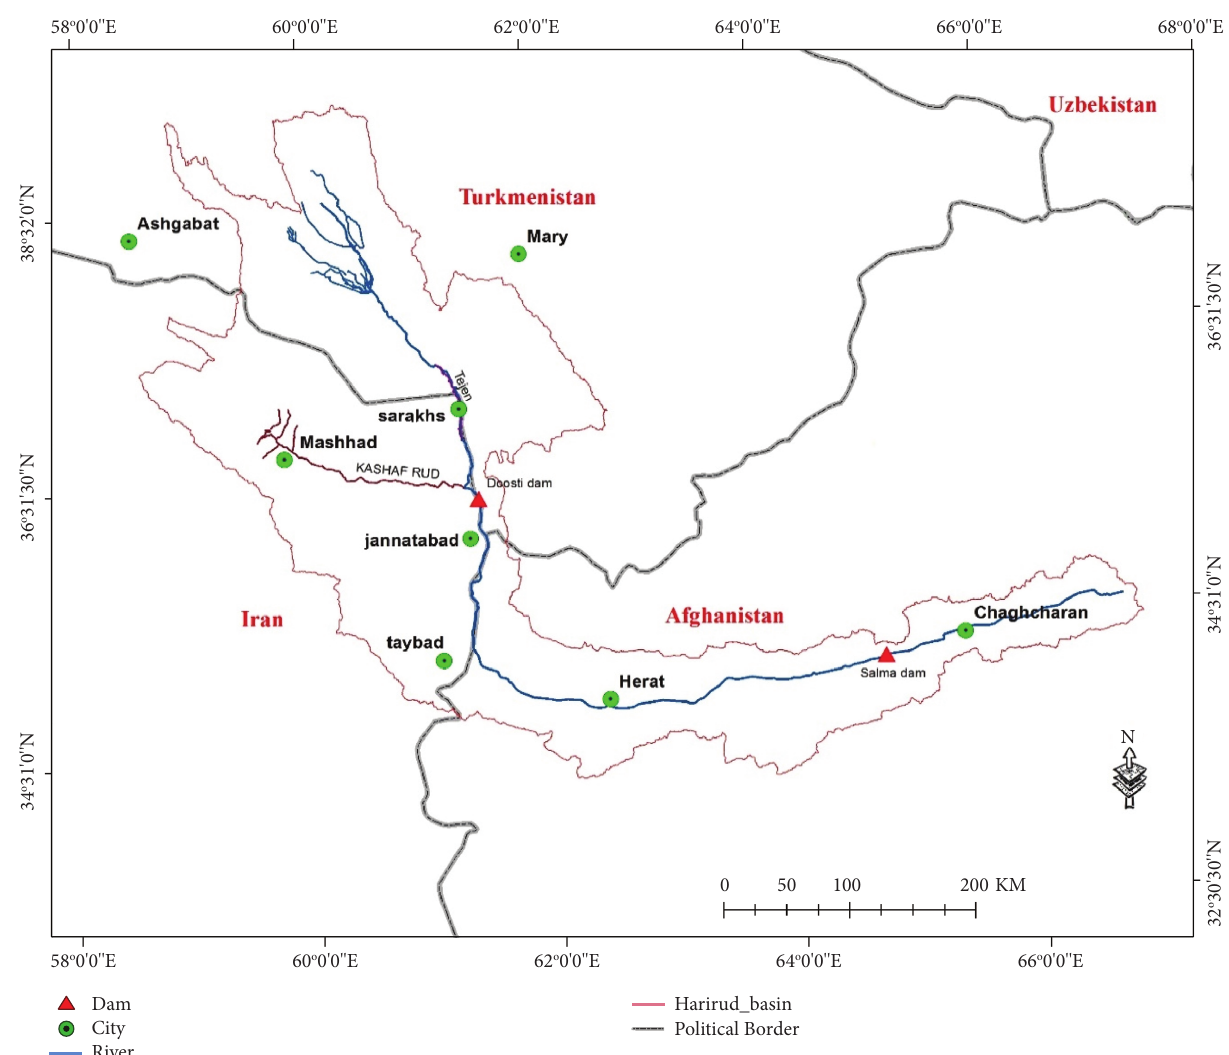
Figure 2: Harirud river basin